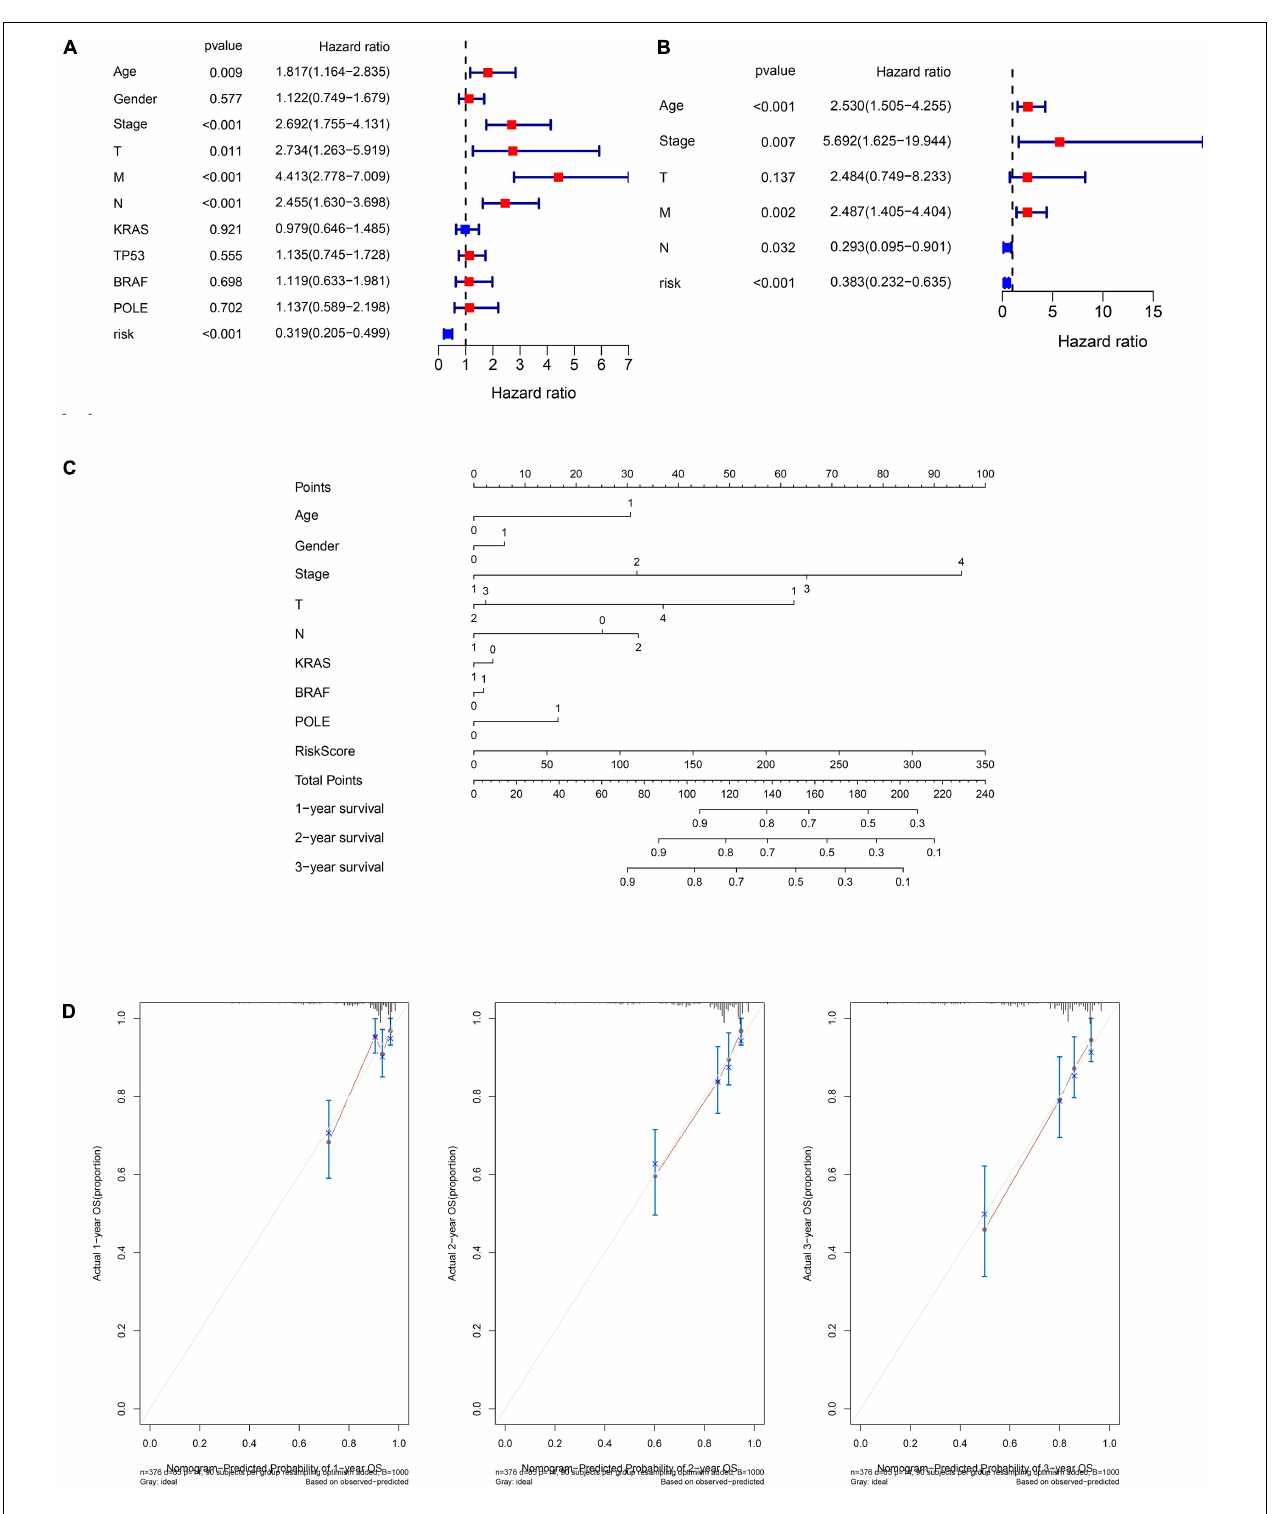
FIGURE 3 | Independent prognostic analysis and nomogram of the 8-lncRNA prognostic signature. (A) Univariate Cox regression of the TCGA cohort. (B) Multivariate Cox regression of the TCGA cohort based on overall survival. Age ( > 65 vs. ≤ 65), gender (male vs. female), stage (III/IV vs. I/II), T (III/IV vs. I/II), M (I vs. 0), N (I/II vs. 0), KRAS (mutation vs. wild), TP53 (mutation vs. wild), BRAF (mutation vs. wild), POLE (mutation vs. wild), and risk (low-risk vs. high-risk). (C) Nomogram of the TCGA cohort based on overall survival (M was not included in the nomogram due to only 20 patients with M1). (D) Calibration curve of the TCGA cohort based on overall survival at 1, 2, and 3